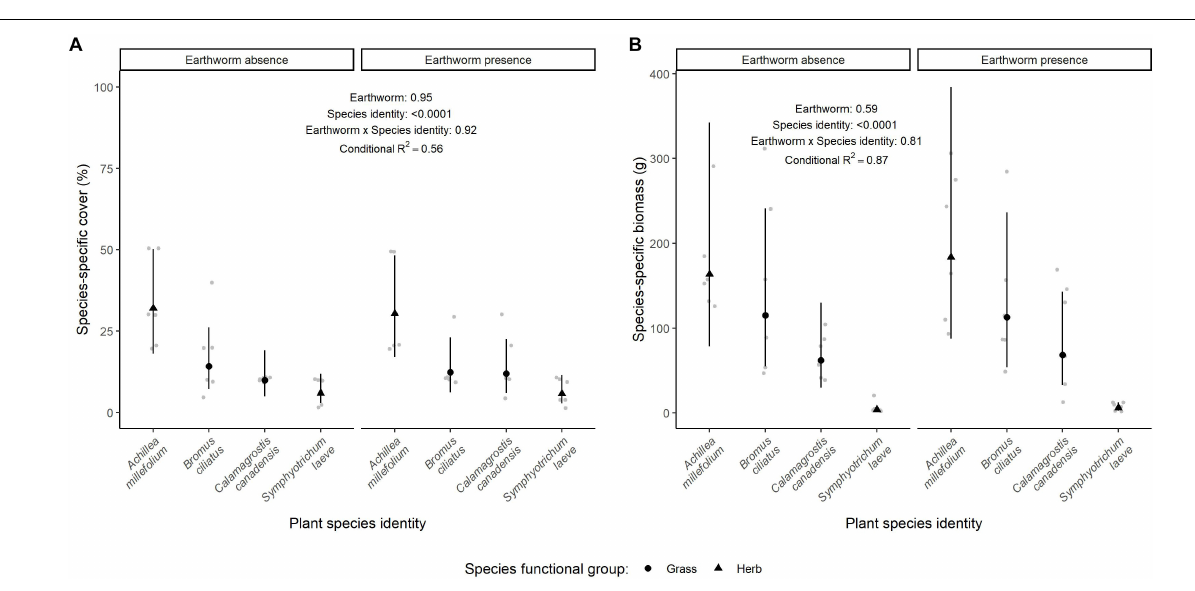
FIGURE 2 | Effect of earthworm presence on species-specific cover (A) and biomass (B) . Estimated marginal means and confidence intervals are shown in black (after being back-transformed), while data points are included in the background in gray. The conditional R 2 as well as the p -values for each factor are based on linear mixed effect models. Number of observations per species and treatment: